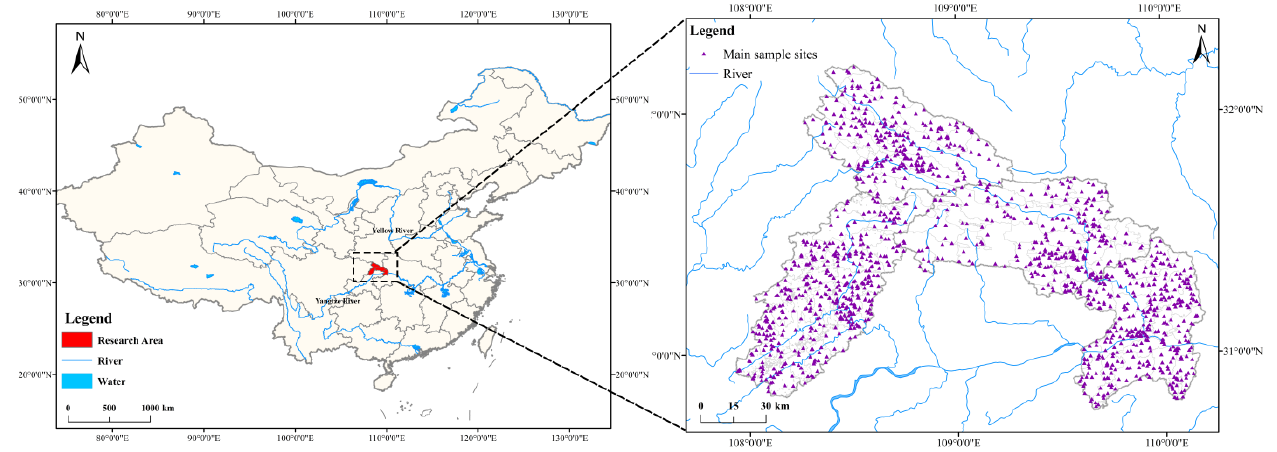
Figure 1. Distribution of invasive alien species (IAS) of the southern side of the Daba Mountain area, China. The geographic coordinate system used in maps is the China Geodetic Coordinate System 2000. Table 1. The levels of the risk assessment index system.